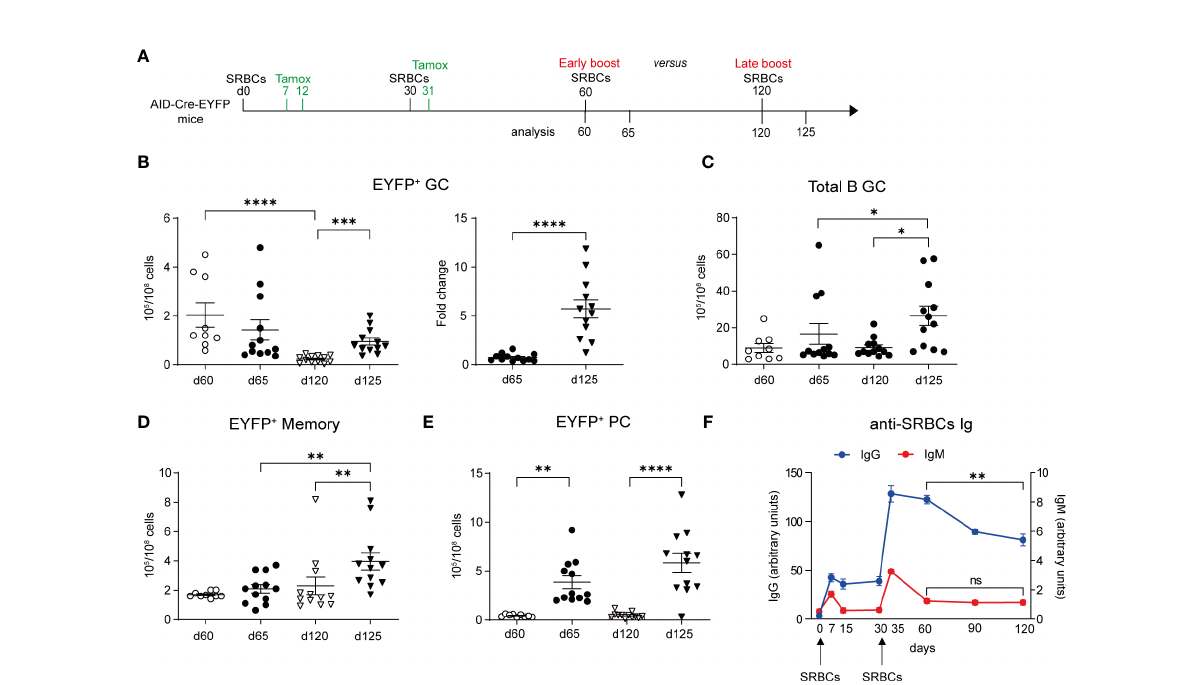
FIGURE 5 Longer time between prime and boost favors GC and memory recall responses. (A) AID-Cre-EYFP mice were immunized twice with SRBCs (d0 and 30) and received tamoxifen upon prime and boost (d7, 12, 31). Spleen cells were analyzed by fl ow cytometry on d60 or 120. Alternatively, mice received a third early or late SRBC boost at, respectively, d60 or 120 and were analyzed at d65 or 125. (B) EYFP + GC cell numbers are shown in the left graph for both boost schedules. On the right, the fold change of EYFP + GC cell numbers on d65 and 125 related to the average cell number observed before the early and late boosts is shown. Numbers of total B220 + GL7 + GC B cells (C) , EYFP + memory (D) and PCs (E) are shown in the corresponding graphs. (F) anti-SRBC IgM and IgG titers, represented as arbitrary units, were determined by ELISA from serum of mice that received SRBC injections on d0 and 30. Curves are obtained by analyzing serum collected longitudinally from 6 mice from d0 until d120. Each point in the graphs represents an individual mouse from at least two independent experiments (B – E) . Means ( ± SEM) are shown. Kruskal-Wallis analysis with uncorrected Dunn ’ s test was performed to compare the different conditions in panels (B) (graph on the left) – E . Mann Whitney test was used to compare results in panel (B) (graph on the right) and d60 vs 120 from graph in panel (F)